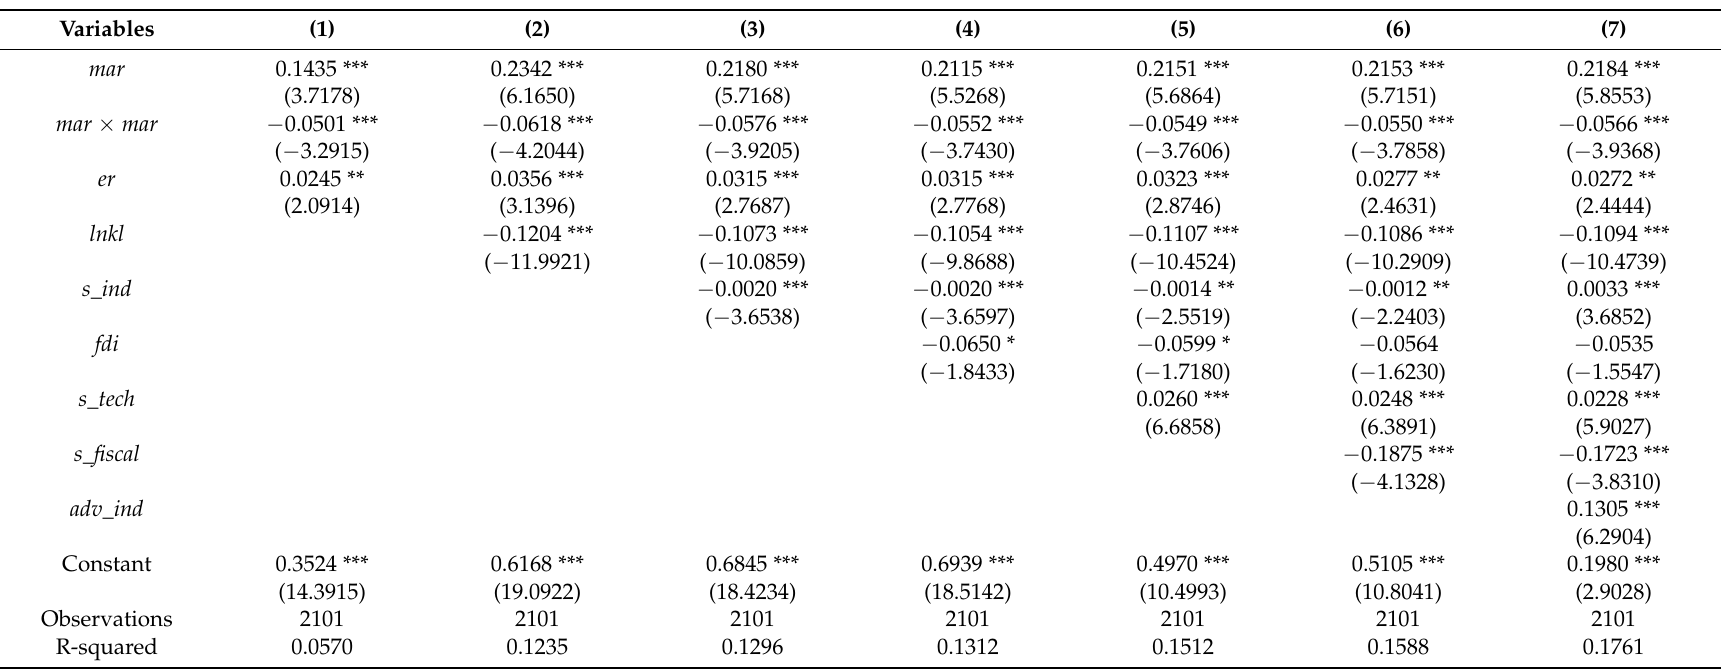
Table 2. Estimation results of MAR externality and urban